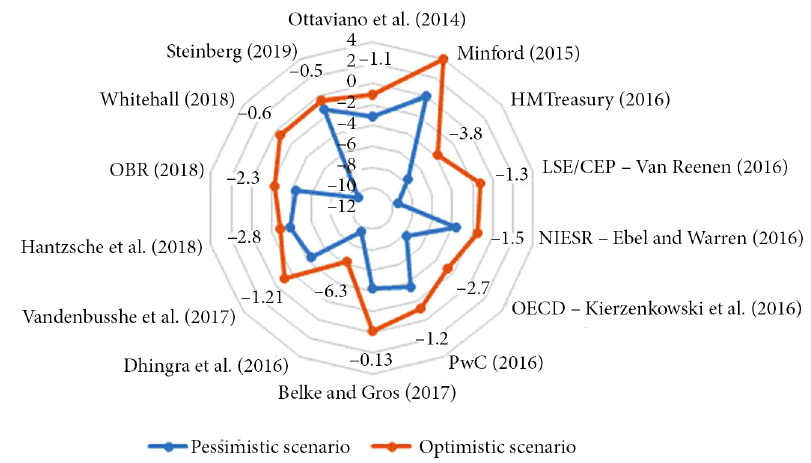
Figure 1. The long-term impact of Brexit on GDP in the economic literature (by